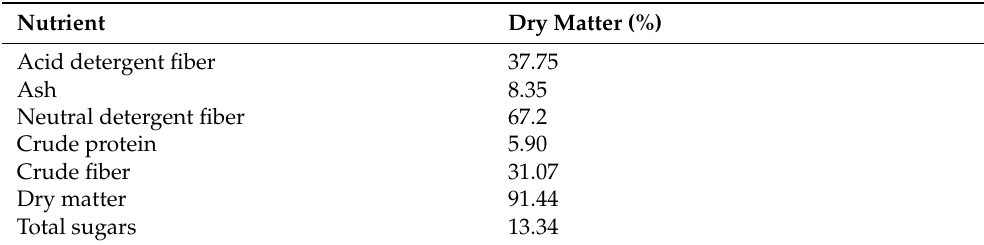
Table 1. Chemical composition of corn stover used as substrate for in vitro ruminal fermentation.